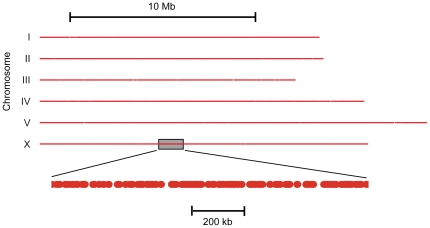
Genomic coverage of Mos1.Graphical representation of each C. elegans chromosome showing the regions of the genome that are potentially amenable to genome engineering using the publicly-available Mos1 alleles; it is assumed that any point up to 1.5 kb away from a transposon-insertion site can be targeted. The bottom line is a magnified view of the boxed region on chromosome X.